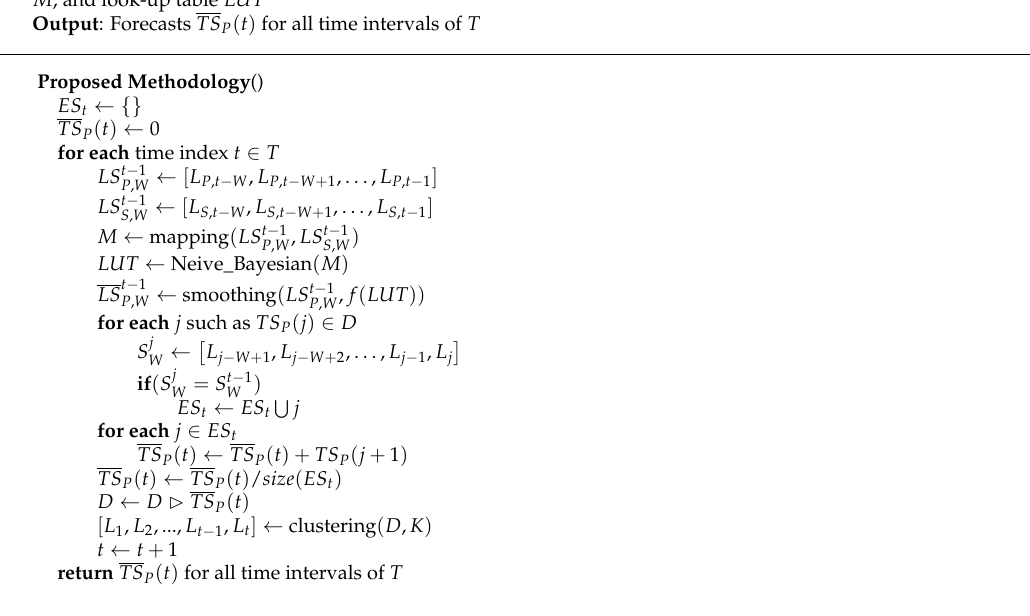
Figure 4. Pseudocode for the proposed